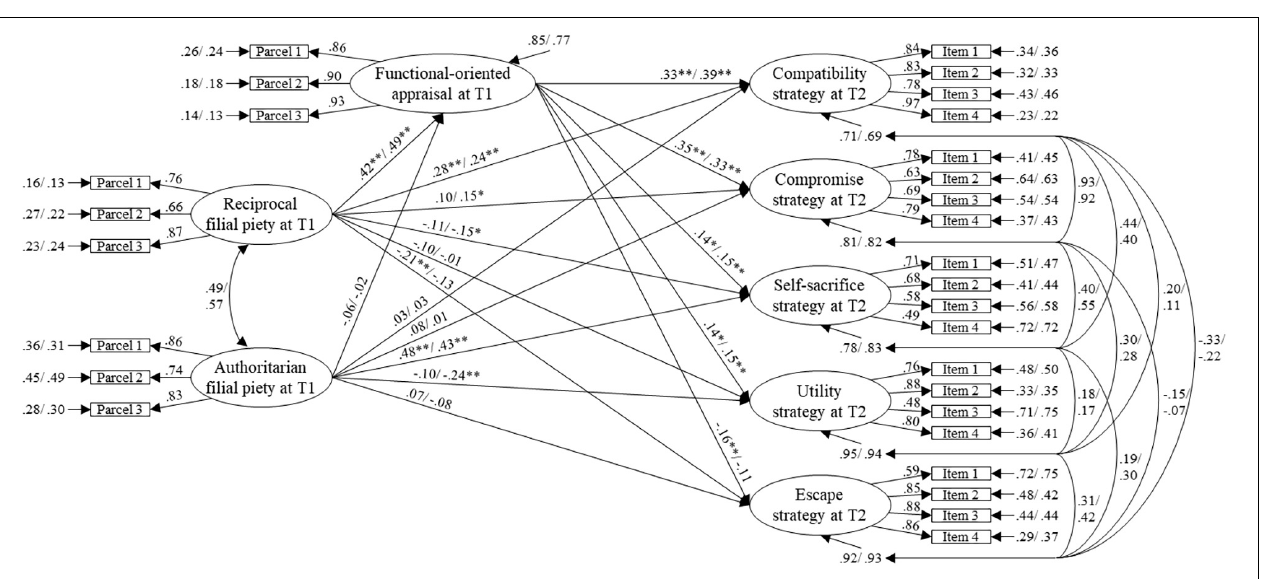
(estimate = − 0.27, SE = 0.06, p < 0.001) and